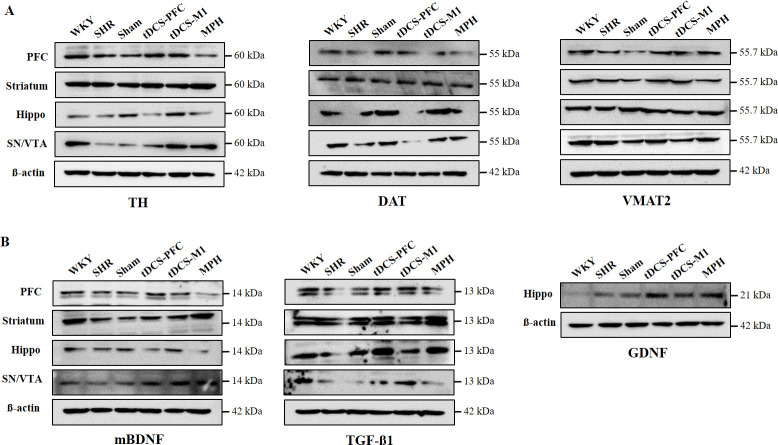
Effect of HD-tDCS on protein expression of dopaminergic neurotransmission factors and NTFs in a rat model of ADHD.Representative western blots for dopaminergic neurotransmission factors and NTFs (A) TH, DAT, and VMAT2, (B) mBDNF, TGF-ß1, and GDNF in the core regions of dopaminergic projections. β-Actin was used as the loading control.